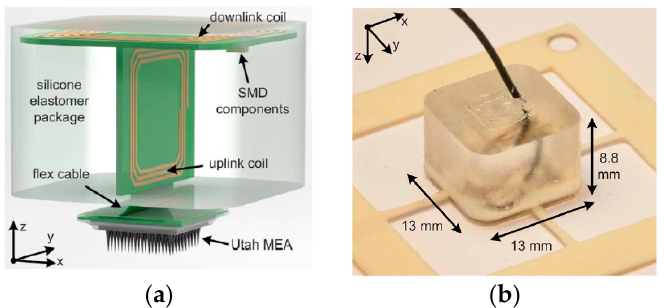
Figure 10. Proposed two-body packaging for a wireless cortical implant [107]. ( a ) Components of the package. ( b ) Fabricated package. Copyright © 2011, IEEE.